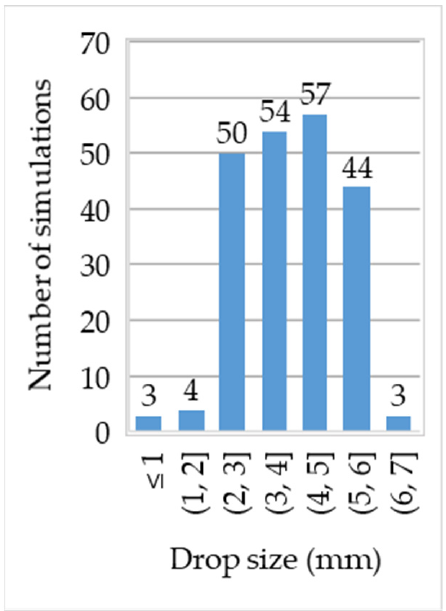
Figure 6. The number of simulations at different sizes of drop diameter. Note: drippers whose corresponding drop diameter sizes were given in a range were excluded from the analysis.